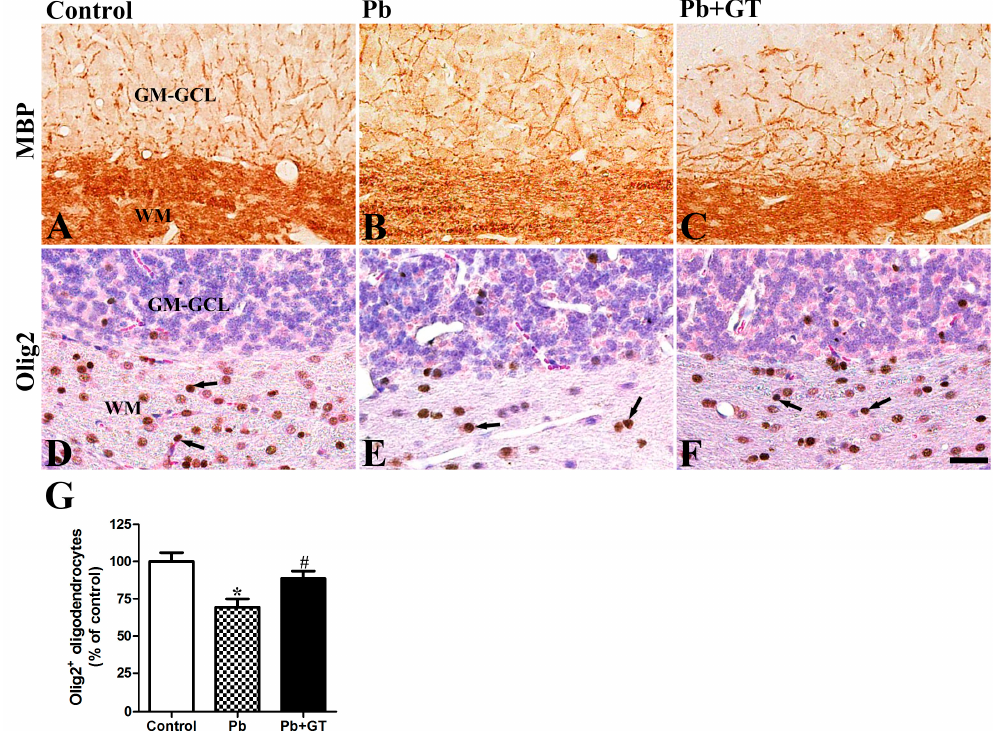
Figure 6. Effects of gintonin on Pb-induced cerebellar MBP and Olig2. Immunohistochemistry of MBP ( A – C ) and Olig2 ( D – F ) in the cerebellum of offspring from control, Pb, and Pb plus gintonin (Pb + GT) groups. Note that MBP-positive myelinated fibers and Olig2-immunoreactive oligodendrocytes (arrow) are detected in the cerebellum. Pb-induced reduction in the number of Olig2-immunoreactive oligodendrocytes is significantly ameliorated by gintonin treatment. The intensity of MBP staining in white matter (WM) ( B ) decreases after Pb exposure, with gintonin treatment ameliorating these observed reductions. MBP, Myelin basic protein; GM-GCL, granular cell layer in gray matter; WM, white matter. Bar = 25 μ m. ( G ) The number of Olig2-immunoreactive